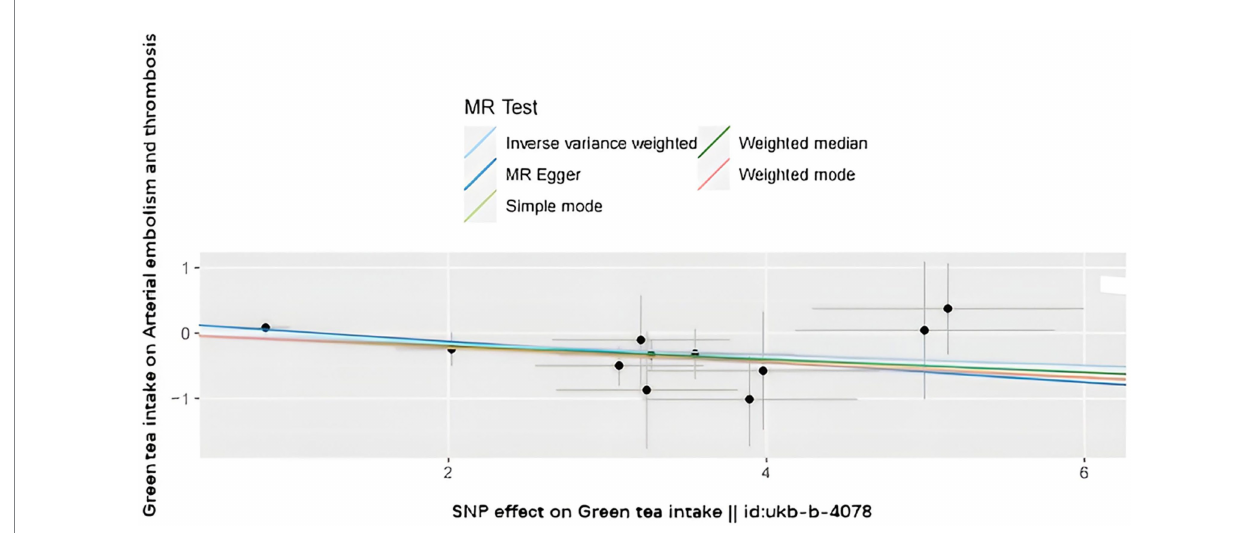
FIGURE 2 Scatter plot to visualize the causal effect of hypertension on the risk of ED. The slope of the straight line shows the magnitude of the causal association. IVW indicates inverse-variance weighted; and MR, Mendelian randomization.